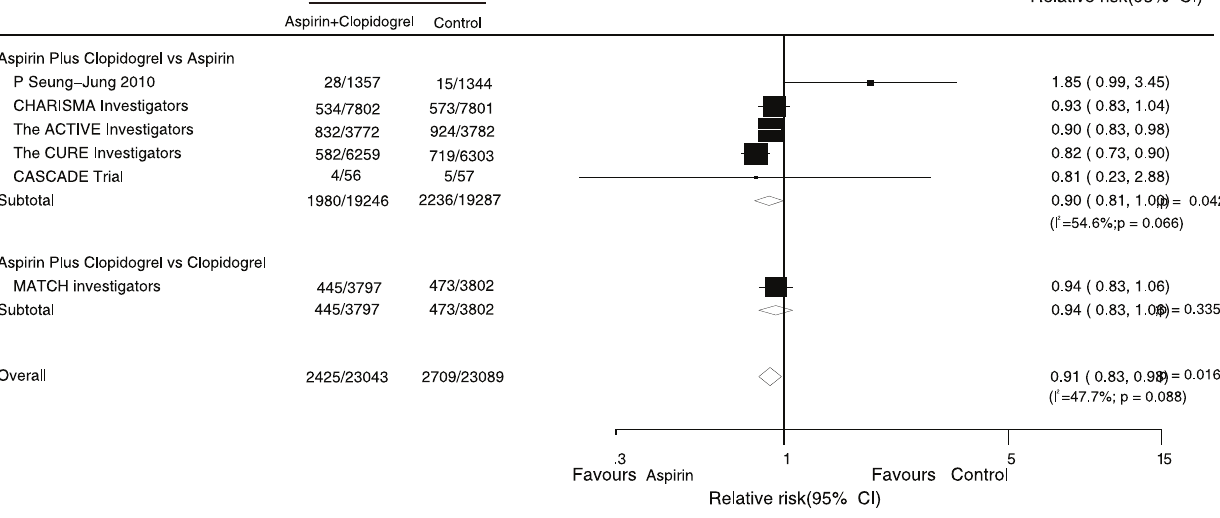
Figure 2. Effects of aspirin with clopidogrel therapy on risk of major cardiovascular events.